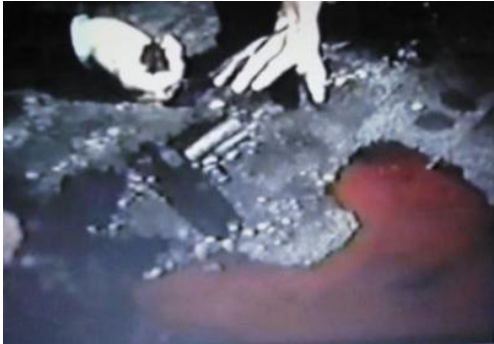
Figure 5: Shot from When love possesses us, in Bresson’s Four nights of a dreamer